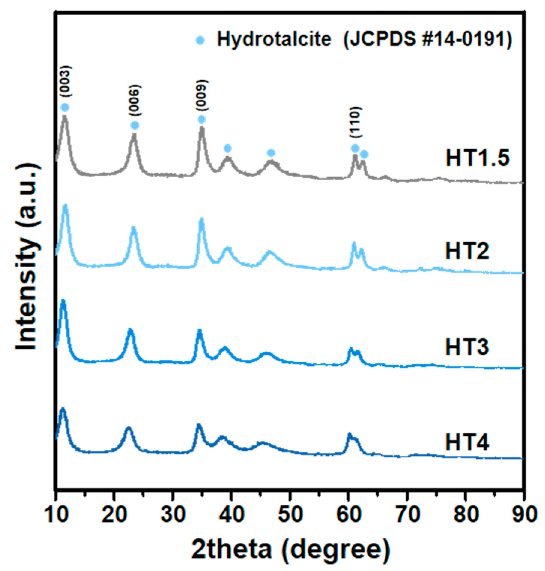
Figure 2. X-ray di ff raction (XRD) patterns of the prepared HTX catalysts (X = 1.5, 2, 3, and Figure 2. X-ray diffraction (XRD) patterns of the prepared HTX catalysts (X = 1.5, 2, 3, and 4).